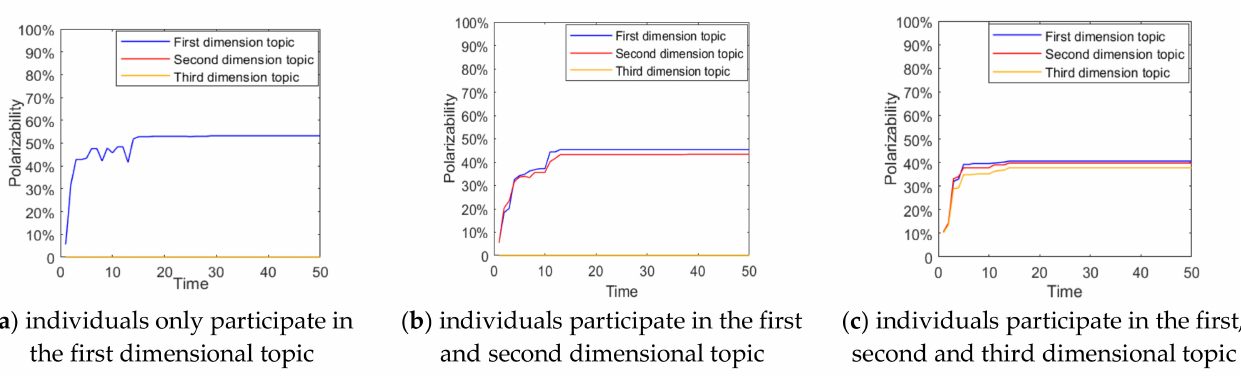
Figure 4. The polarizability of group attitude when individuals participate in different